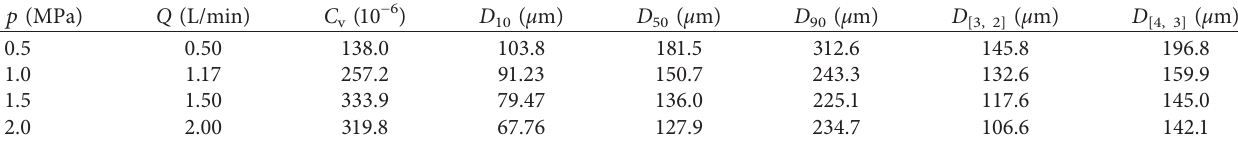
Table 2: Atomization characteristics of nozzle under different water supply pressures.